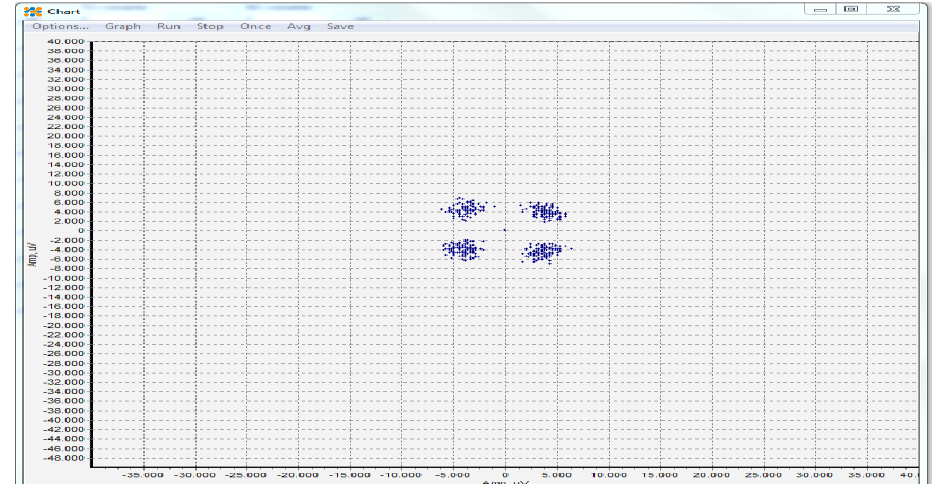
Figure 7. Graphic representation of the QPSK constellation related to the received signals, using the Analog Devices software tool IIO Oscilloscope.